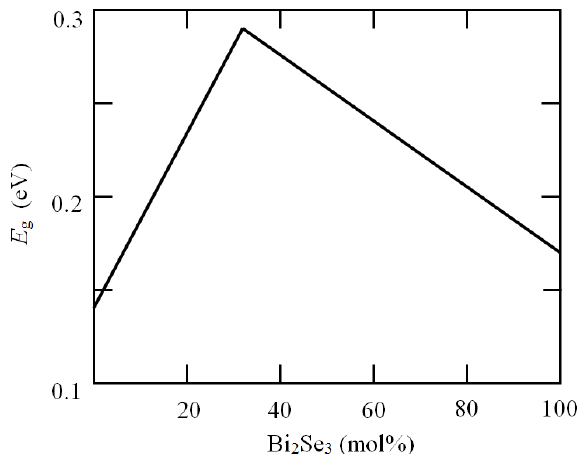
Figure 2. Variation of energy gap with concentration of Bi on the observations of Greenaway and Harbeke